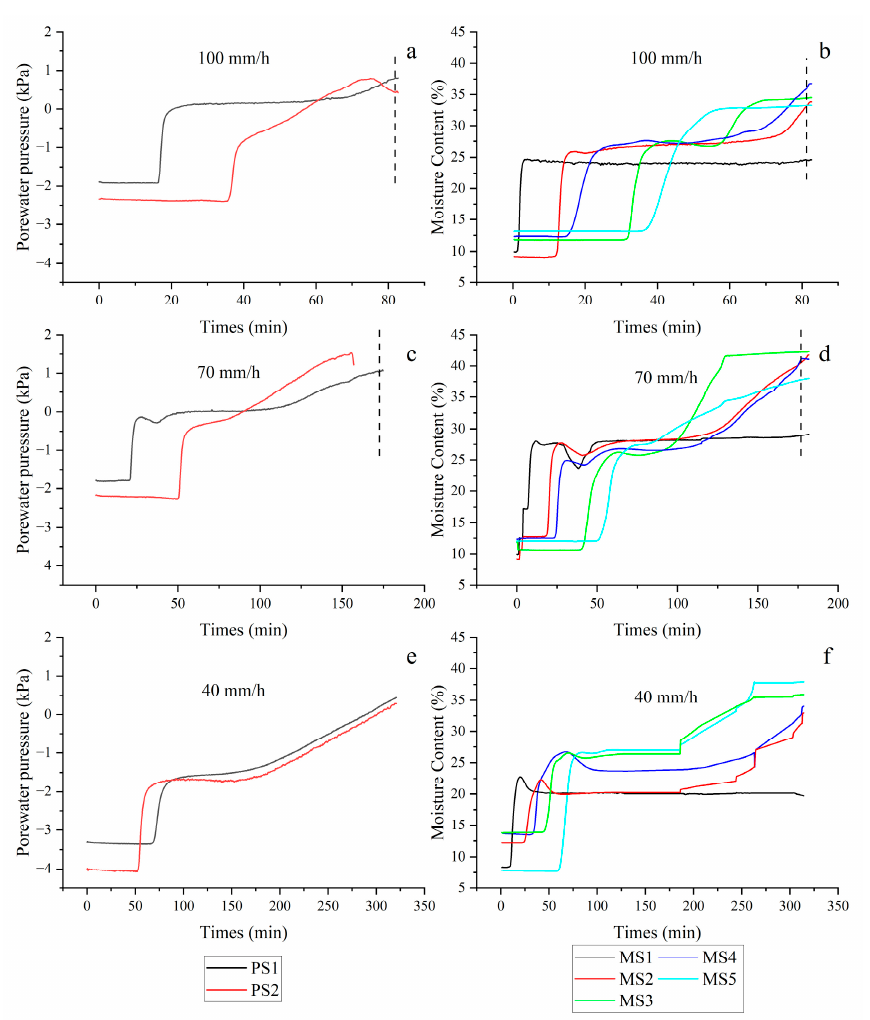
Figure 4. Time series data of pore water pressure ( a , c , e ) and water content ( b , d , f ). The following values rainfall intensity were used: 100 mm/hour ( a , b ), 70 mm/hour ( c , d ), and 40 mm/hour ( e , f ).